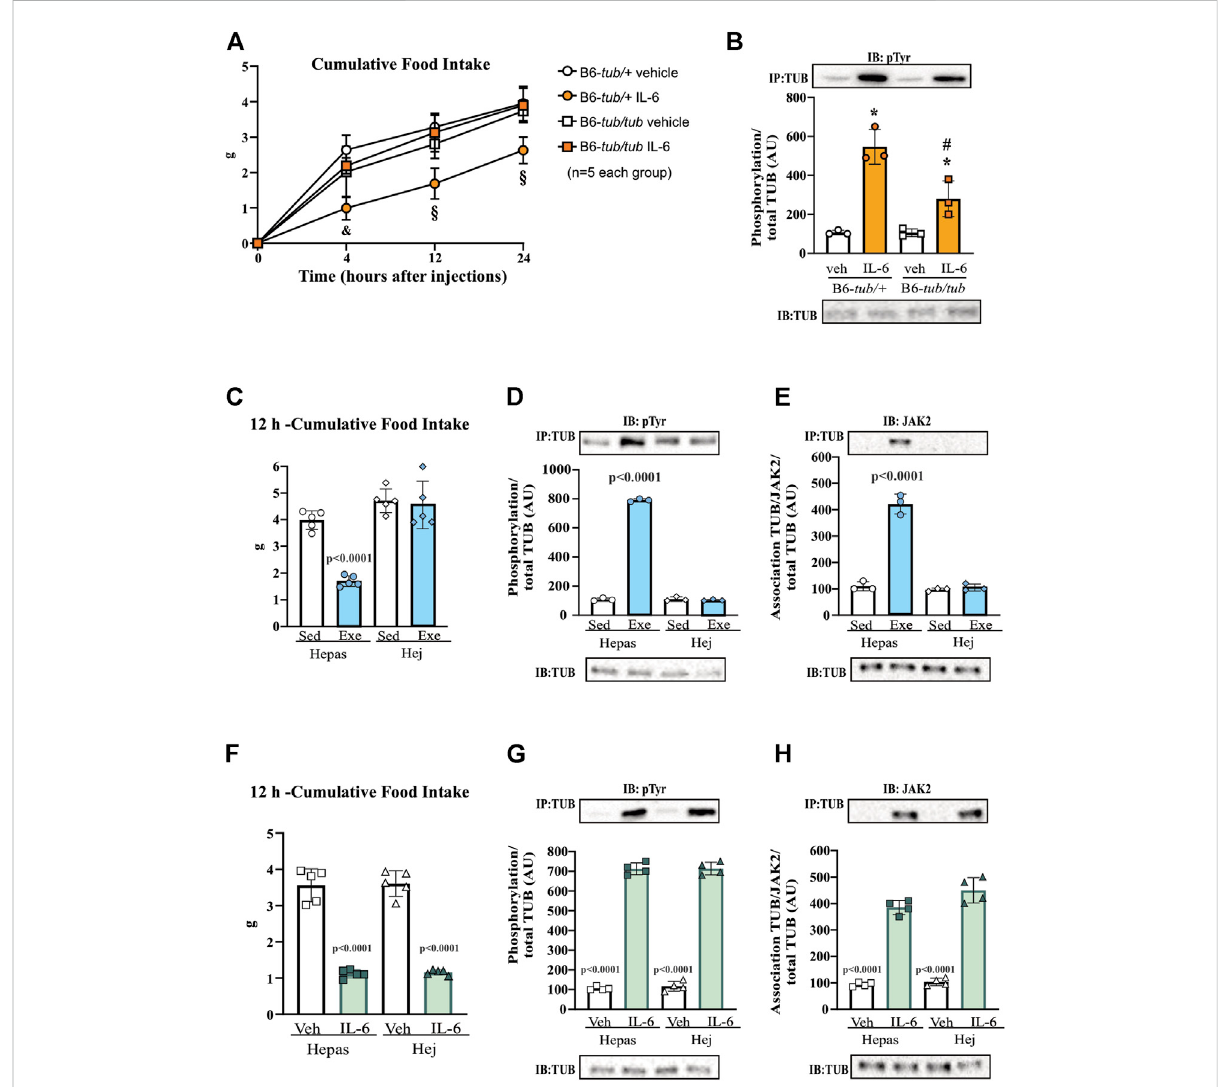
FIGURE 2 Effects of IL-6 on food intake and TUBregulation. (A) Evaluation ofcumulative food intake (g) at 4 h, 12 h, and 24 h ( n = 5each group); Western blotshowing (B) TUBtyrosinephosphorylationfromhypothalamuslysatesfromyoung(6 – 8 weeksofage)heterozygous(B6- tub/+ )orhomozygous (B6- tub/tub ) Tubby mice with vehicle or IL-6 ICV injection. (C) 12 h of cumulative food intake (g) ( n = 5 each group); Western blot showing (D) TUB tyrosine phosphorylation, and (E) TUB associated with JAK2 from hypothalamus lysates from lean C3H/Hepas or C3H/HeJ mice under resting conditions (Sed) or after swimming exercise (Exe). (F) 12 h of cumulative food intake (g) ( n = 5 each group); Western blot showing (G) TUB tyrosine phosphorylation, and (H) TUB associated with JAK2 from hypothalamus lysates from lean C3H/Hepas or C3H/HeJ mice treated with vehicle or